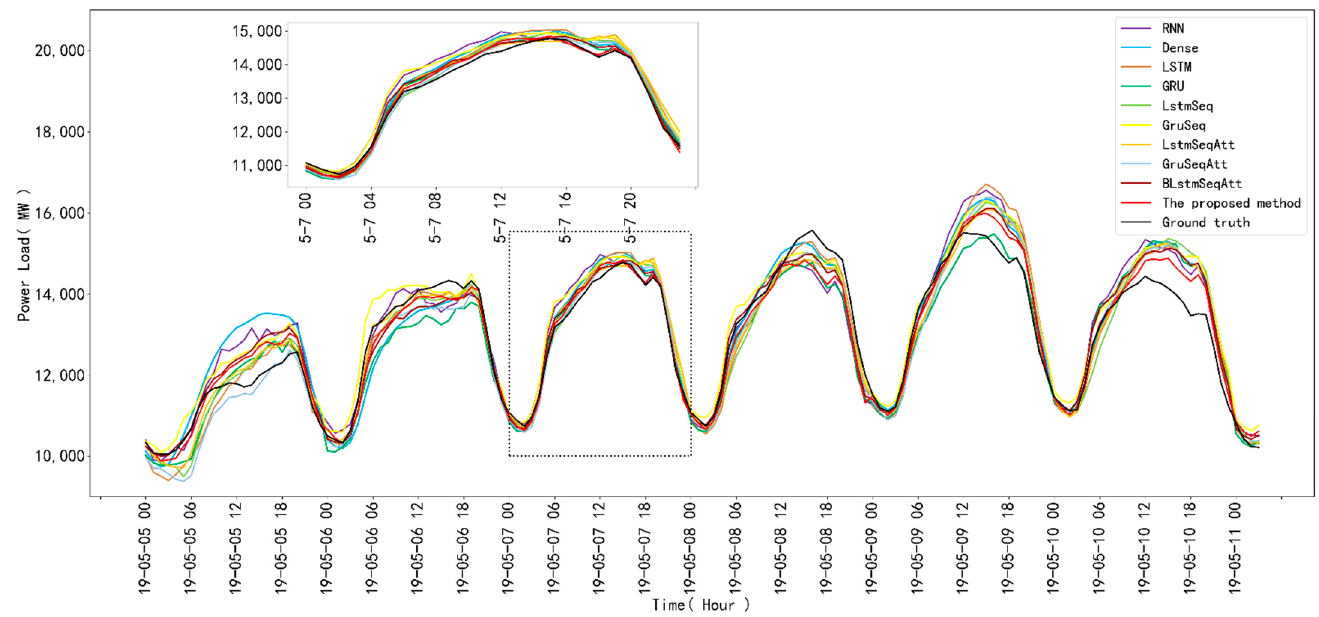
Figure 7. Prediction results of the power load by different models.